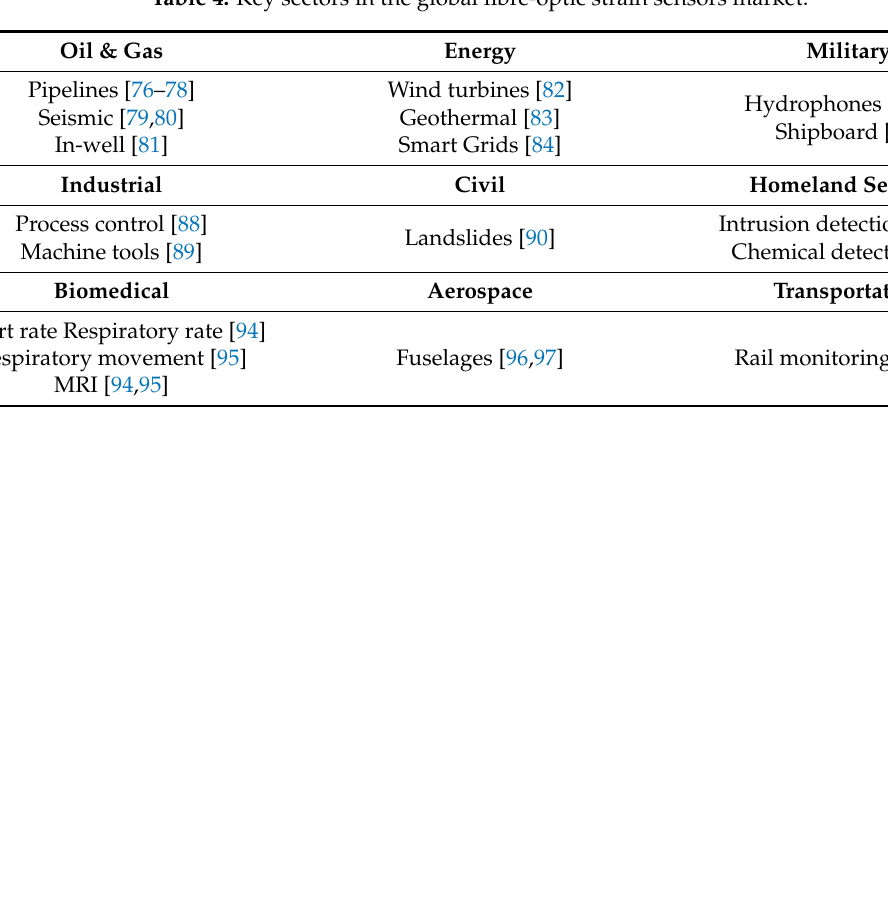
Table 4. Key sectors in the global fibre-optic strain sensors